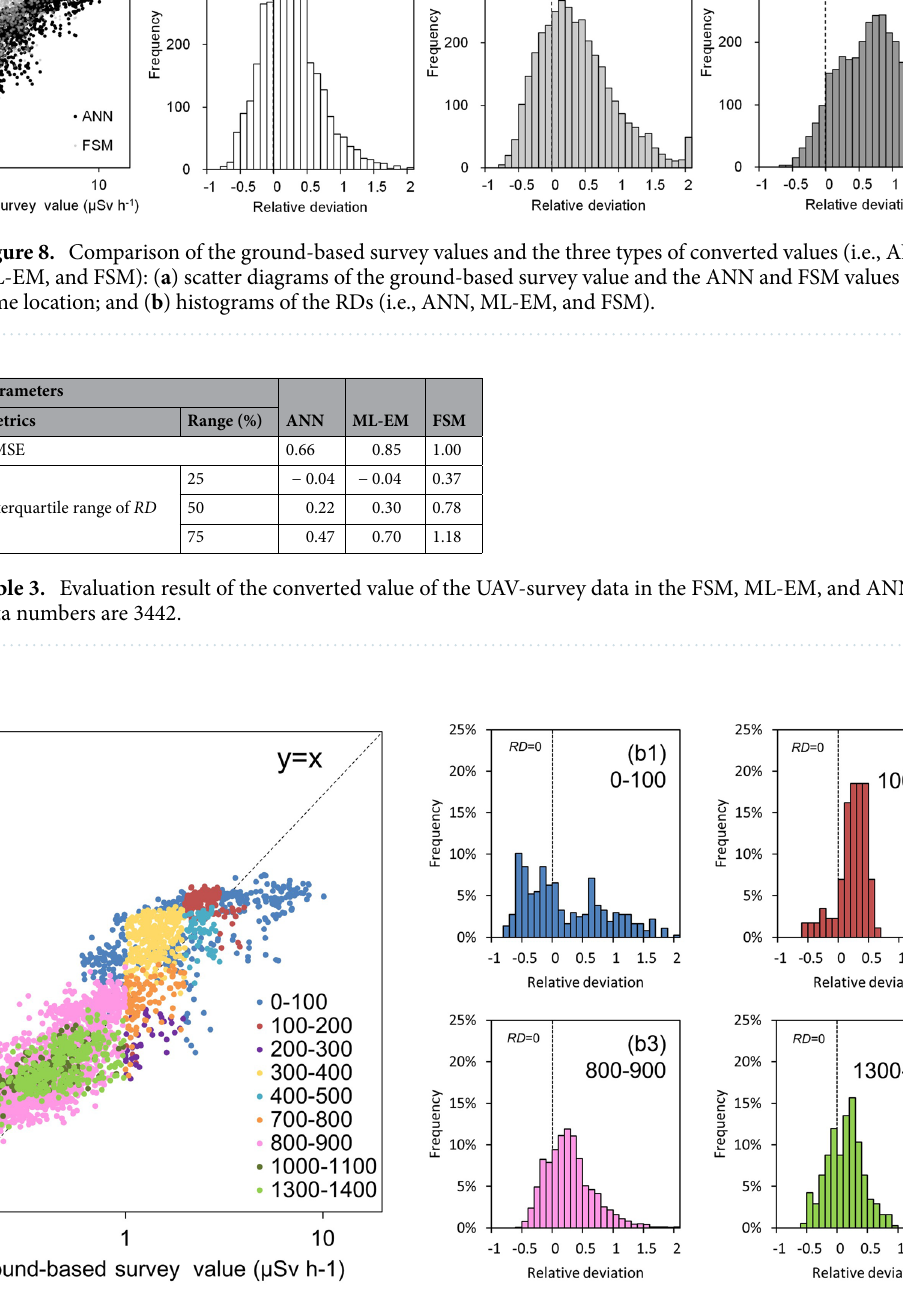
Figure 9. Comparison of the ground-based survey values and the ANN conversion values for the number of training cases in the ANN of Fig. 7d: ( a ) scatter diagrams of the ground-based survey value and the ANN value; and ( b ) histograms of the RD for each number of training